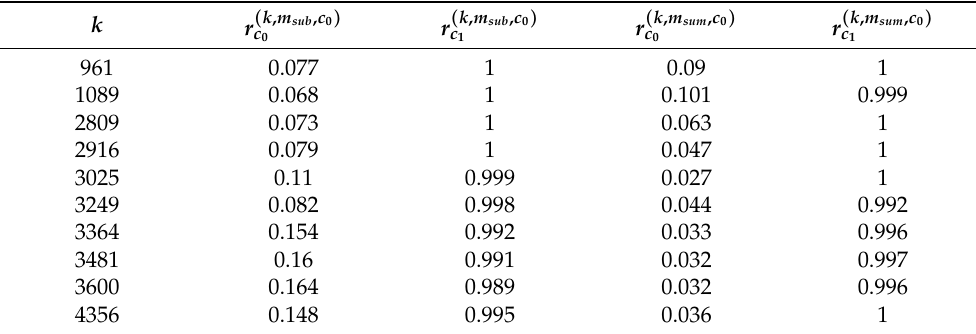
Table 2. The best results obtained in the analysis ( k , m f , c 0 )